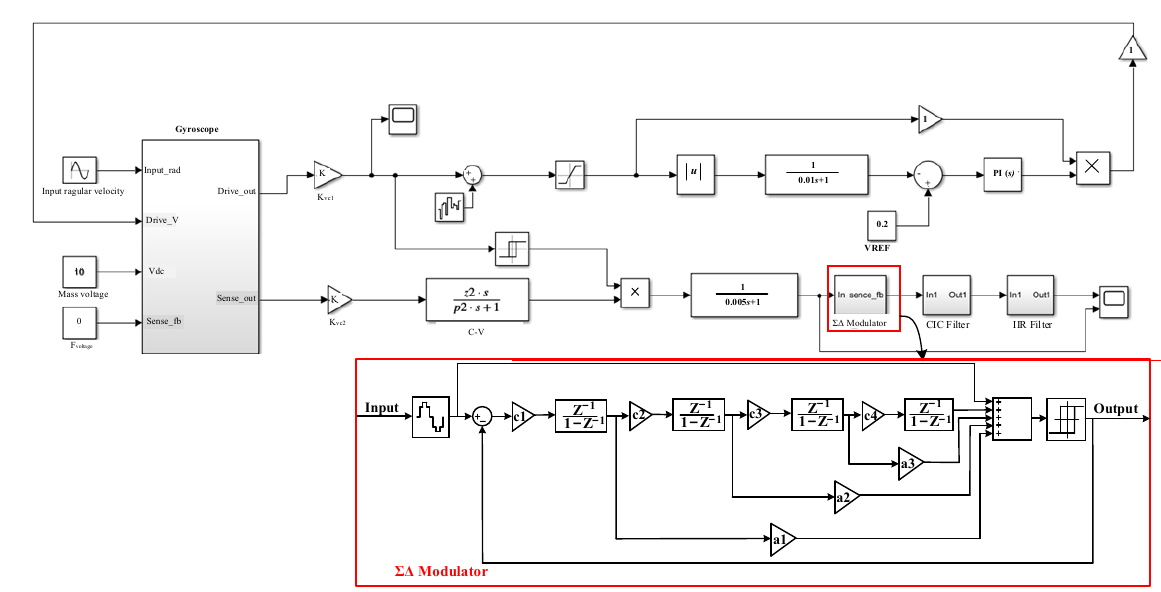
Figure 5. Schematic diagram of gyroscope system-level simulation model.